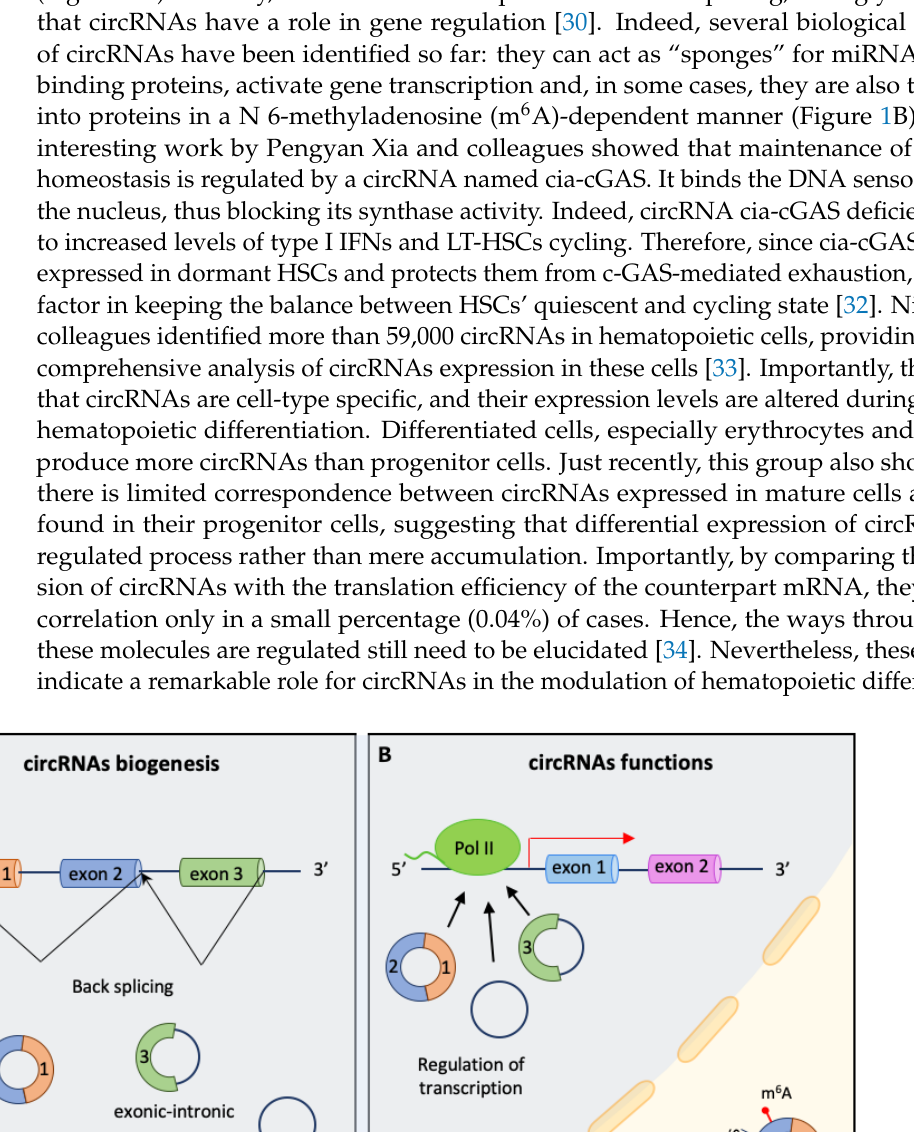
Figure 1. A. circRNAs biogenesis. circRNAs are generated by unconventional splicing, named back-splicing, in which the 3’ end of an exon binds the 5’ end of an upstream exon, forming a co- valently closed molecule. circRNAs can be divided into three main classes: single or multi-exonic circRNAs (on the left), which can translocate in the cytoplasm; exonic-intronic circRNAs (in the middle) and intronic-circRNAs (on the right), which are retained in the nucleus. B. circRNAs func- tions. CircRNAs can regulate transcription, interacting with Polymerase-II (Pol II) in the nucleus. In the cytoplasm, they can act as microRNA sponges or RBP sponges, and they can also be trans- lated thanks to the presence of an IRES or m6A modification. C. circRNAs in AML. Representation of some circRNAs involved in AML progression: circNPM1 acts as miR-345–5p sponge, increasing FZD5 expression, a well-known oncogene; circPAN3, sponging miR-153-5p and miR-183-5p, leads to increased autophagy and inhibits apoptosis; circRNF220 induces MYSM1 and IER2, affecting hematopoiesis and promoting cancer progression and metastasis; circMYBL2 favors mRNA FLT3 translation by binding PTBP1.